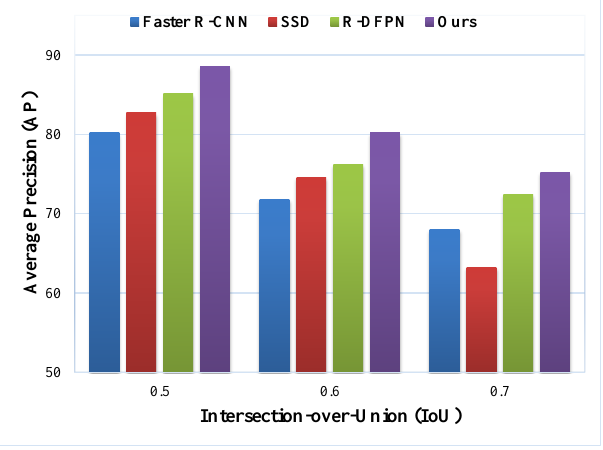
Figure 12. Comparison of AP under different IoU values from the four detection methods.